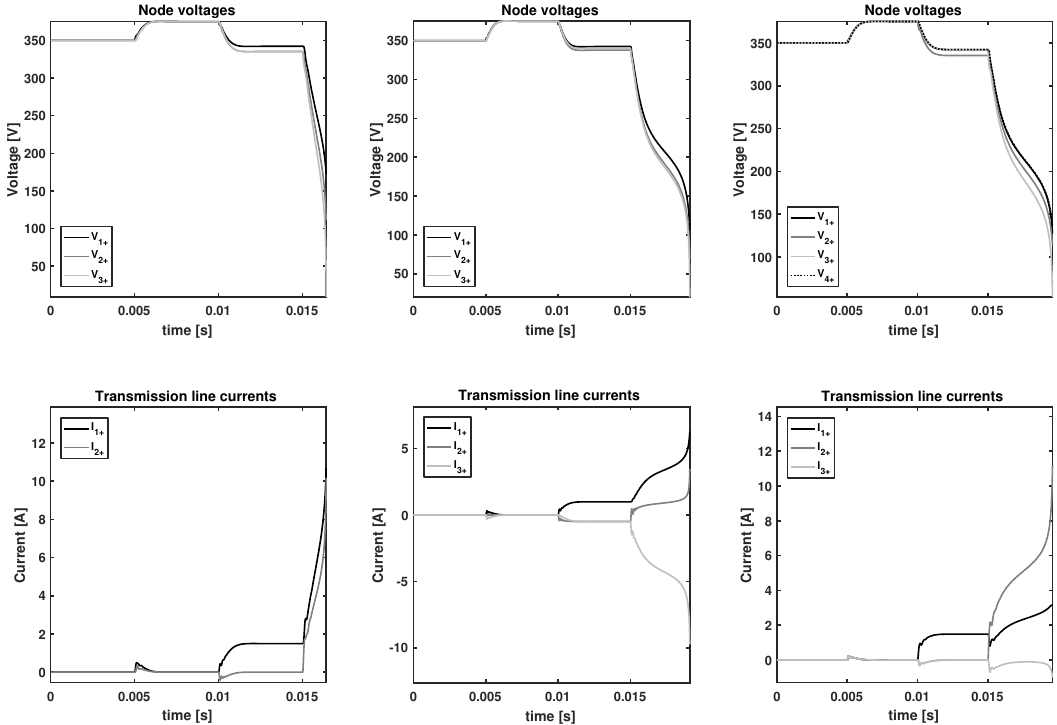
Figure 9. Node voltages and distribution line currents of the bus ( left ), ring ( middle ) and star ( right ) example systems under changing loads and reference voltages, with a droop impedance of 22 Ω